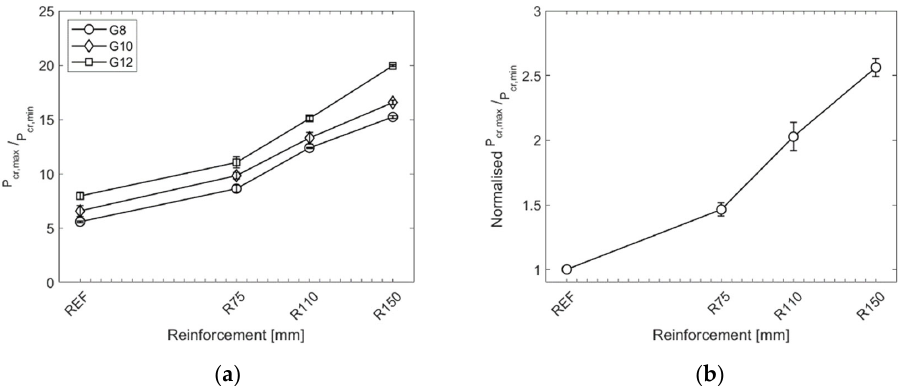
Figure 9. Results of experiments: ( a ) average ratio of P el,max to P cr,min,REF for all specimens; ( b ) normalised values of the ratio P el,max /P cr,min,REF for all specimens.